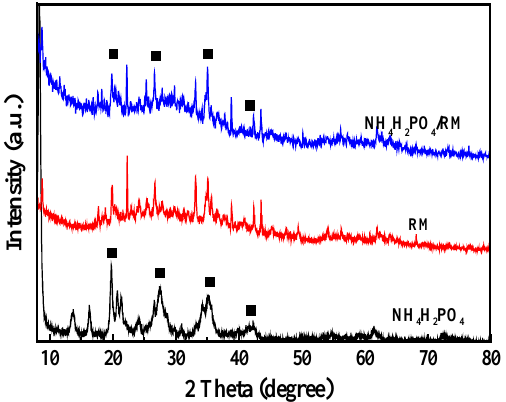
Figure 2. X-ray diffraction (XRD) patterns of NH 4 H 2 PO 4 /RM composite powders, red mud (RM), and NH 4 H 2 PO 4 .